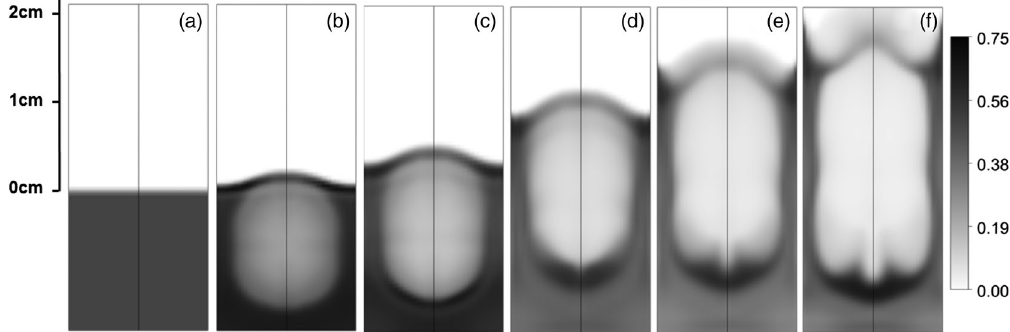
FIG. 4. Simulation of aerodynamic lift of 14 micron diameter tungsten powder in helium at 1 bar, following a beam pulse of 3 × 10 12 protons protons, tungsten powder volume fraction on plane AA at time intervals after the beam pulse, a ¼ 1 μ s, b ¼ 1 ms, c ¼ 2 ms, d ¼ 4 ms, e ¼ 6 ms, and f ¼ 8